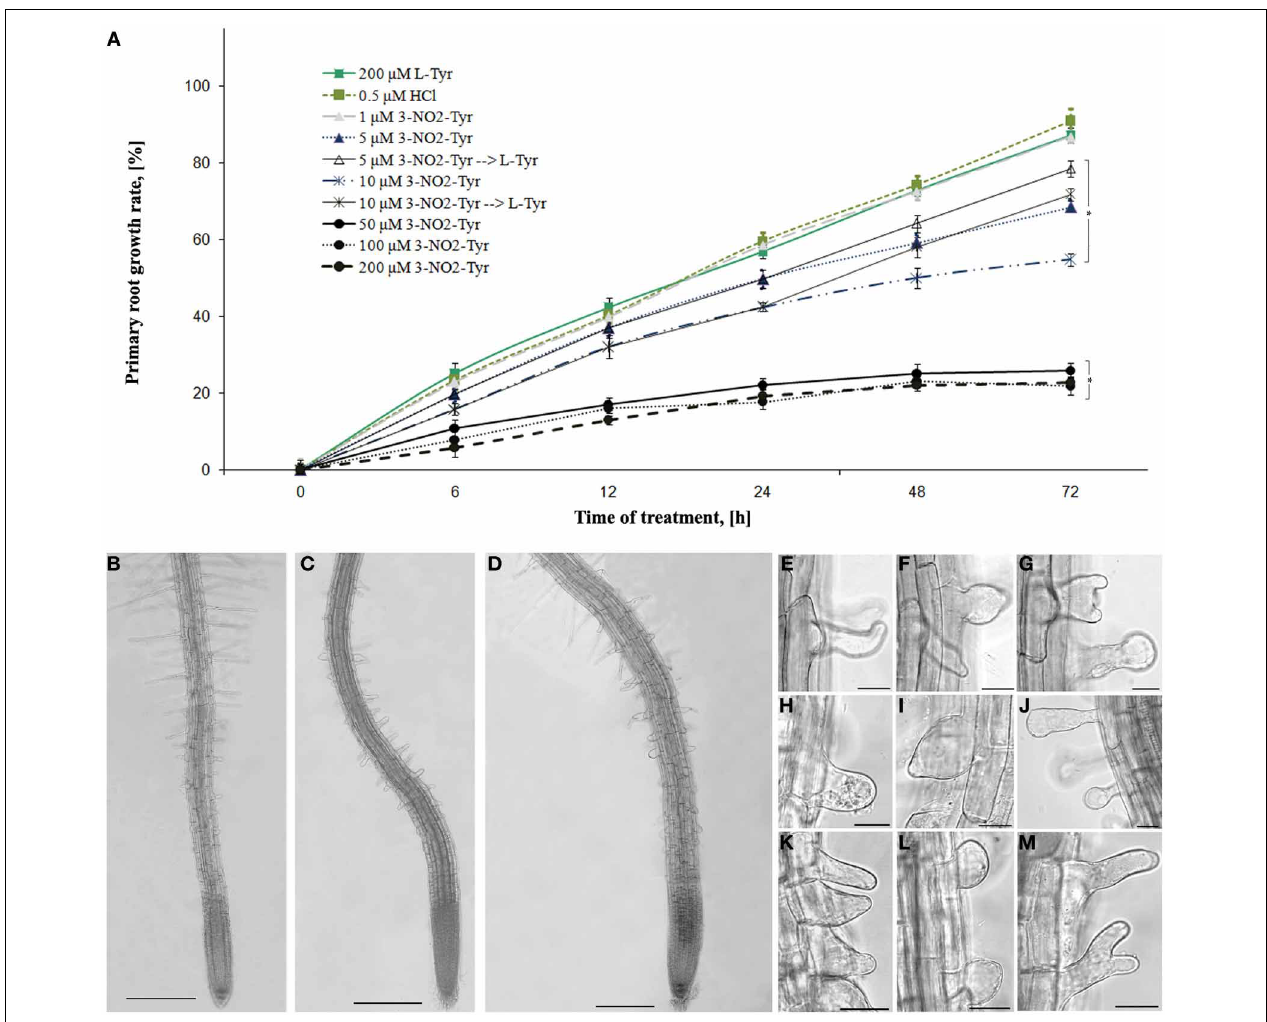
FIGURE 1 | The effects of 3-NO 2 -Tyr on A. thaliana primary roots growth and morphology. (A) Growth rate of A. thaliana roots during 1–200 μ M 3-NO 2 -Tyr treatment for 2–72h. Vertical bars on graphs represent the SE. Columns with asterisk are significantly different ( t -test, P < 0.05) from their